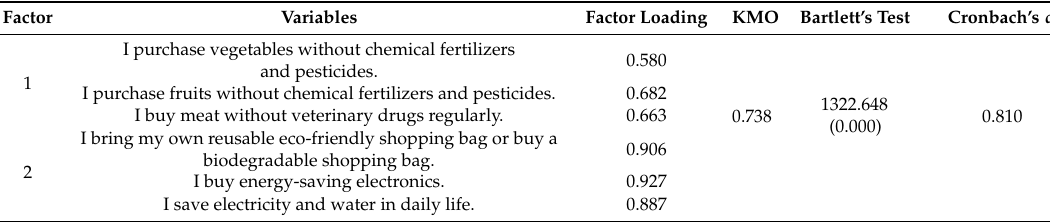
Table A2. Factor analysis results of